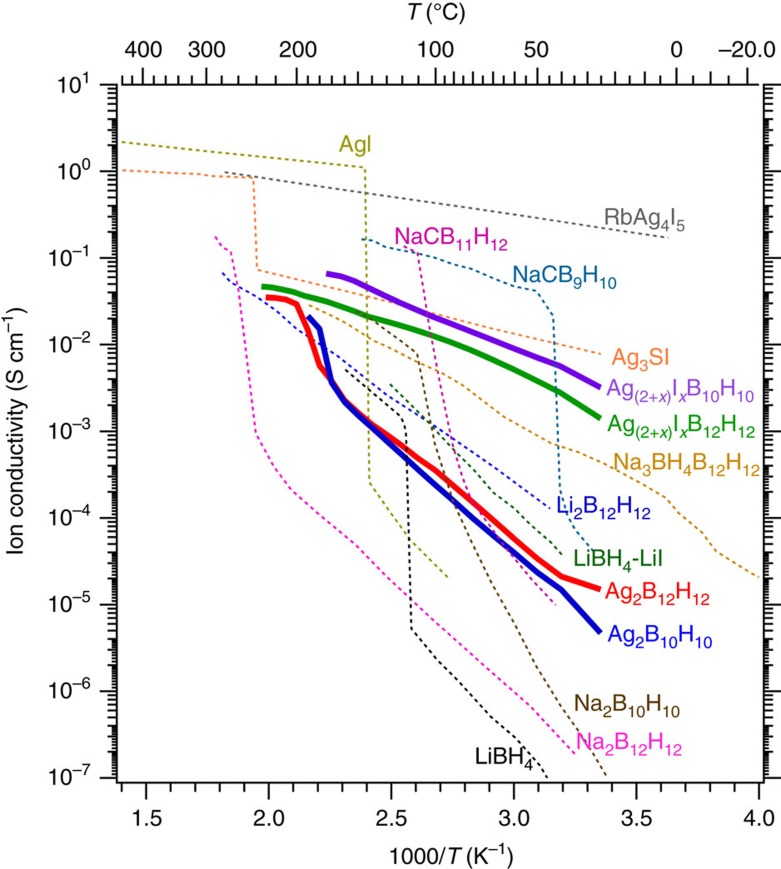
Ion conductivity of the new silver closo-boranes.The data (bold) are displayed in comparison to other silver compounds (AgI, RbAg4I5, Ag3SI)36 and metal boranes from the literature (Na2B10H10 (ref. 7), Li2B12H12 (ref. 8), Na2B12H12 (ref. 8), NaCB9H10 (ref. 21), NaCB11H12 (ref. 20), LiBH4 (ref. 37), LiBH4-LiI (ref. 22), Na3BH4B12H12)38.